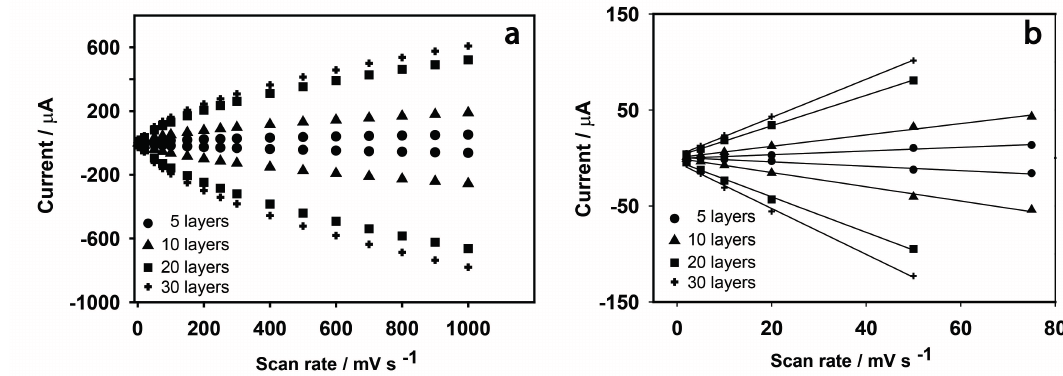
Figure 5. ( a ) Current vs . scan rate (10 to 1000 mV·s − 1 vs . Ag/AgCl) and; ( b ) linear correlation between current and scan rate from 0 to 80 mV·s − 1 for PBNPs-SPEs, demonstrating thin layer